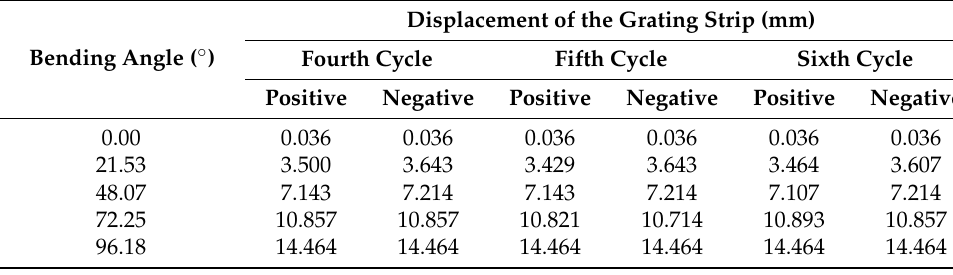
Table 3. Calibration experimental data